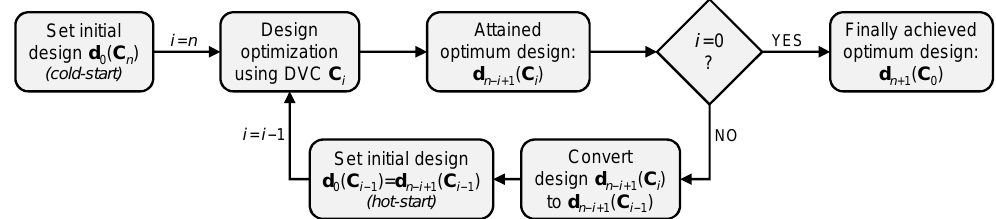
Figure 3. Flowchart of the proposed multi-DVC cascade sizing optimization